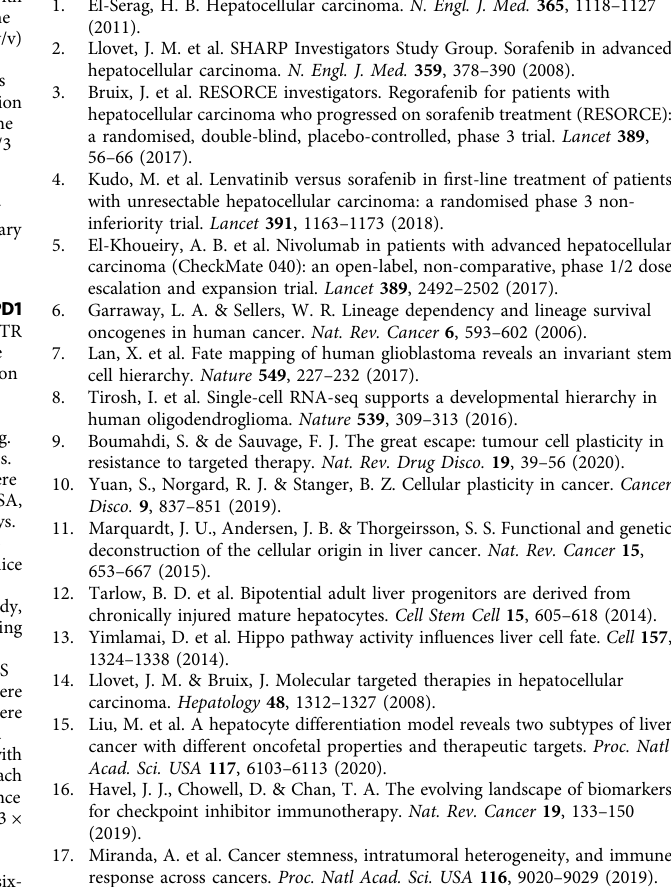
Live animal imaging and in vivo therapeutic treatment of mice with anti-PD1 antibody . To establish a luciferase-labelled orthotopic HCC model, Hepa1-6-CTR or Hepa1-6-GDF1 cells (1 ×10 6 cells/mouse) stably expressing fi re fl y luciferase were injected into the spleens of six-week-old C57BL/6 mice. Tumour formation and metastasis were evaluated with the IVIS Lumina XRMS Series III system (PerkinElmer, USA). Mice were intraperitoneally injected with 15 mg/mL D-luciferin (Gold Biotech, USA) at 150 mg/kg per mouse 5min before imaging. Hepa1 – 6-CTR or Hepa1-6-GDF1 mice were randomly divided into two groups. Once the bioluminescence signal reached 10 5 lux/sec, tumour-bearing mice were treated with an anti-PD1 antibody at a dosage of 100 μg/mouse (Bio X Cell, USA, BP0146) or a rat IgG2a isotype control (Bio X Cell, USA, BP0089) every 3 days. The bioluminescence signals were monitored every 2 days. When the biolumi- nescence signal reached 3× 10 7 lux/sec or the animal ’ s weight reduced >20%, mice were euthanized. To establish a luciferase-labelled metastatic HCC model for in vivo combination treatment of mice with LSD1 inhibitor and anti-PD1 antibody, Hepa1-6-CTR or Hepa1 – 6-GDF1 KO cells (1.5 × 10 6 cells/mouse) stably expressing fi re fl y luciferase were injected into the spleens of six-week-old C57BL/6 mice. Tumour formation and metastasis were evaluated with the IVIS Lumina XRMS Series III system. Once the bioluminescence signal reached 10 5 lux/sec, mice were randomised into 4 groups. For treatment with antibody, tumour-bearing mice were treated with an anti-PD1 antibody at a dosage of 100 μg/mouse or a rat IgG2a isotype control every 3 days. For LSD1 inhibitor treatment, mice were treated with 10mg/kg of GSK-LSD1 (MCE, HY-100546A) or vehicle (4% DMSO in saline) each week (4 consecutive days followed by a 3-day holiday, i.p.). The bioluminescence signals were monitored every 2 days. When the bioluminescence signal reached 3 × 10 7 lux/sec or the animal ’ s weight reduced >20%, mice were euthanized. To establish a GDF1 KO -metastatic HCC model, Hepa1-6-GDF1 KO cells (3.5 × 10 6 cells/mouse) stably expressing fi re fl y luciferase were injected into the spleens of